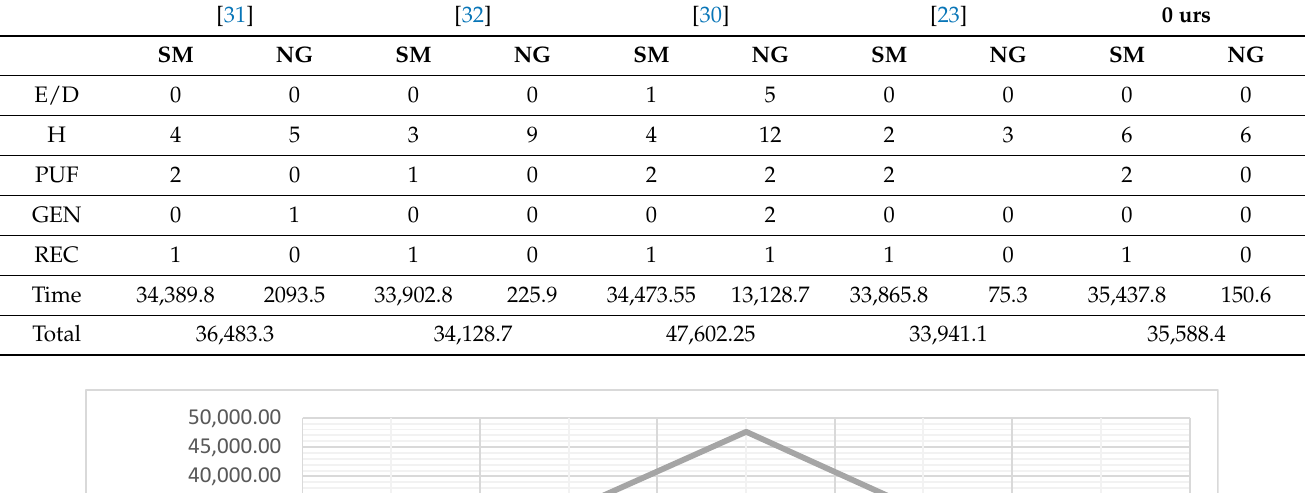
Table 3. Cost comparison of different protocols versus the proposed protocols.